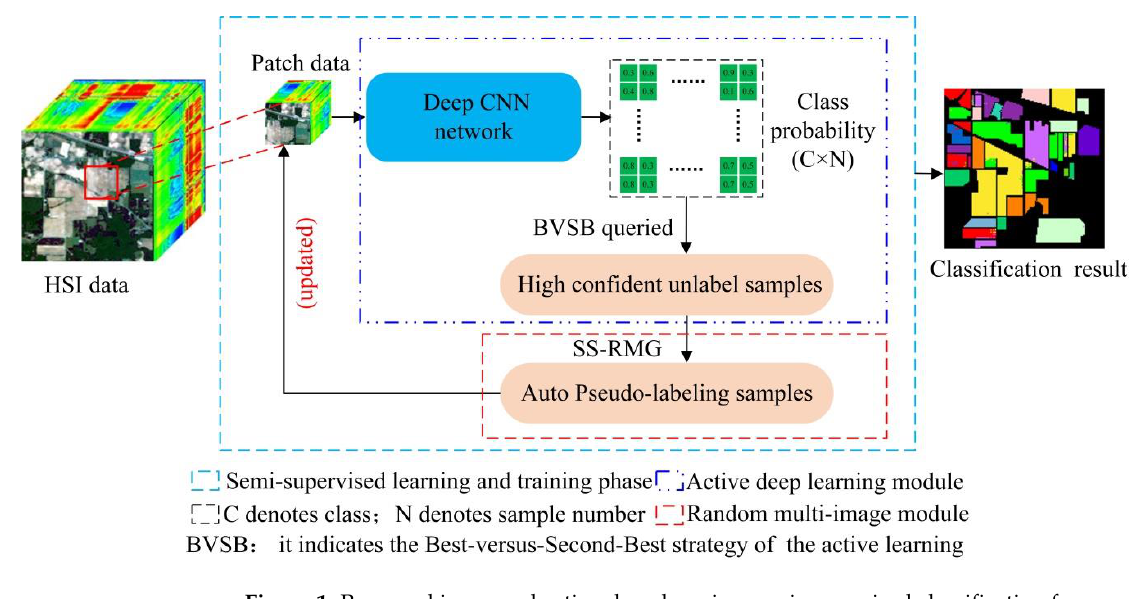
Figure 1. Proposed improved active deep learning semi-supervised classification framework.